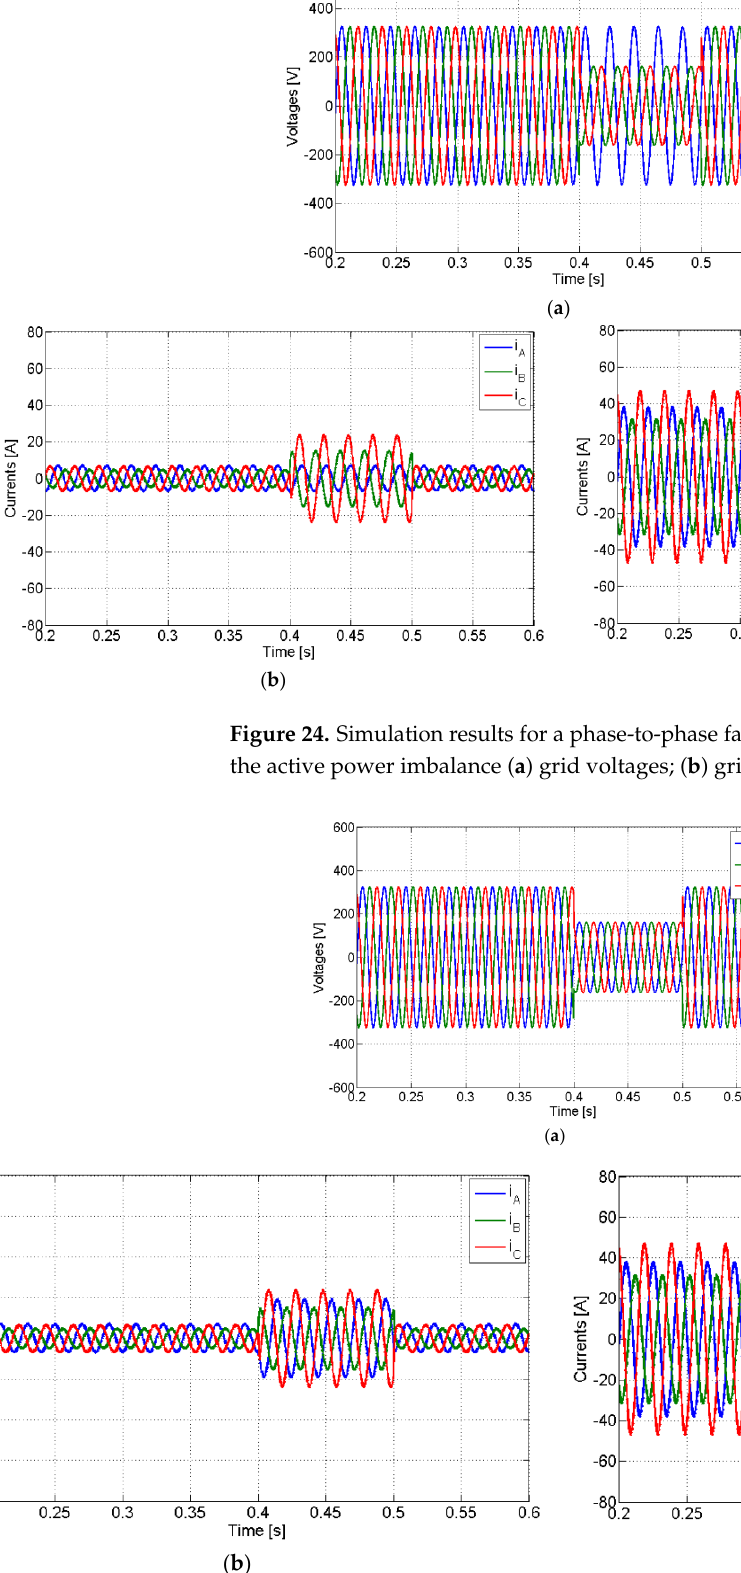
Figure 25. Simulation results for a three-phase fault using a non-linear load and compensation of the active power imbalance: ( a ) grid voltages; ( b ) grid currents; ( c ) AC currents of the PV generator.